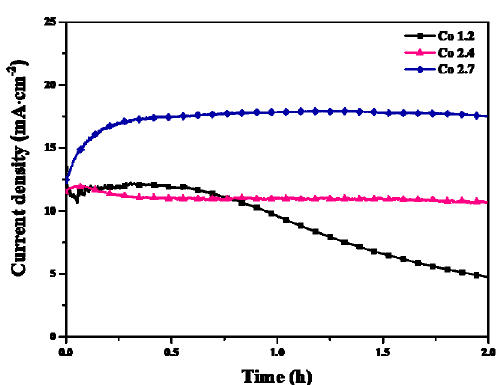
Figure 11. Chronoamperometry curve of Co- and Mn-based the mixed phase materials (Co = 1.2, 2.4, and 2.7) under an applied voltage where a current density of 10 mA · cm − 2 is generated.